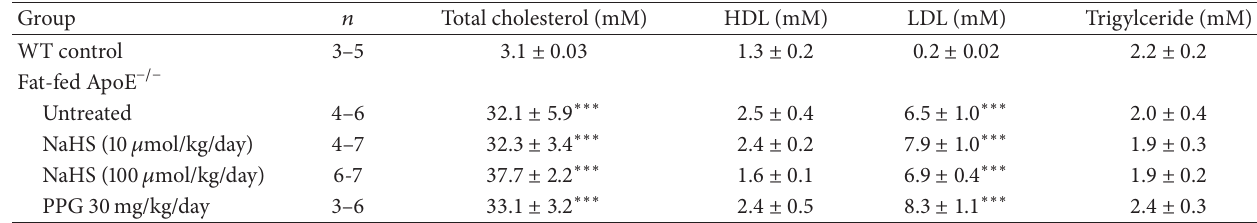
Table 1: Effect of chronic treatment with NaHS or PPG on plasma lipid profile.